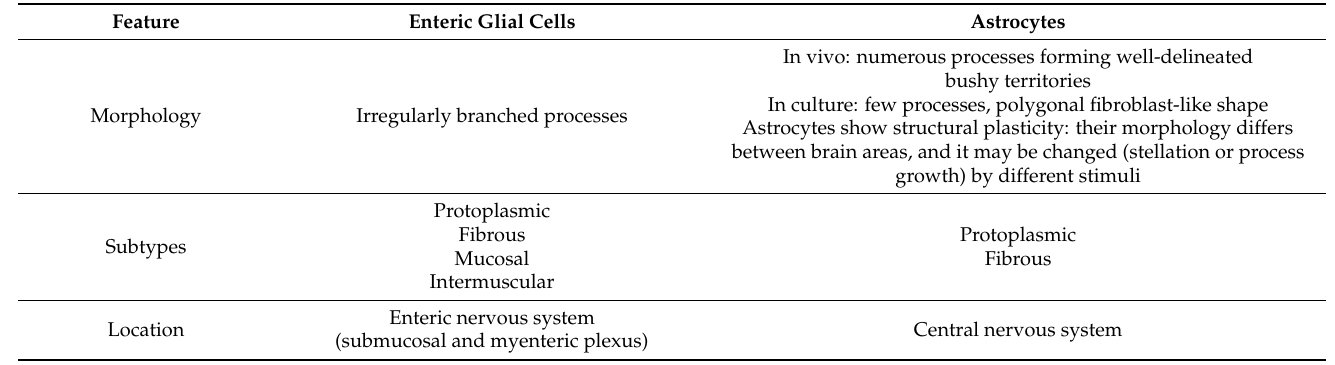
Table 2. Comparison between enteric glial cells and astrocytes